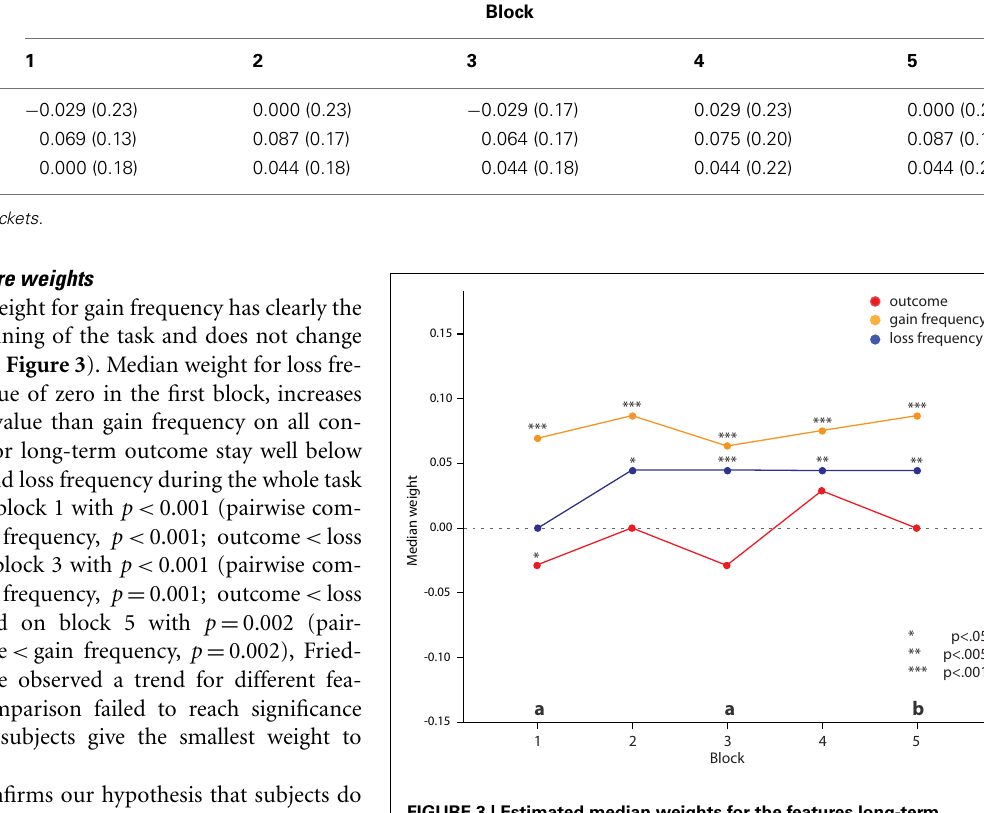
frequency − 0.46),75.6% of subjects belonged to cluster 2 (median weight for outcome 0.09, loss frequency 0.04, and gain frequency